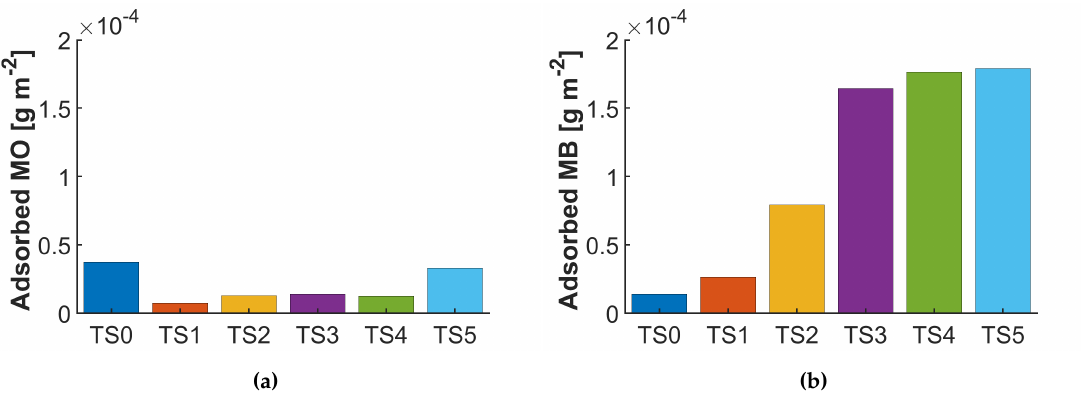
Figure 4. Adsorption studies of a blind and different core-shell samples of ( a ) methyl orange (MO) and the ( b ) methylene blue (MB).